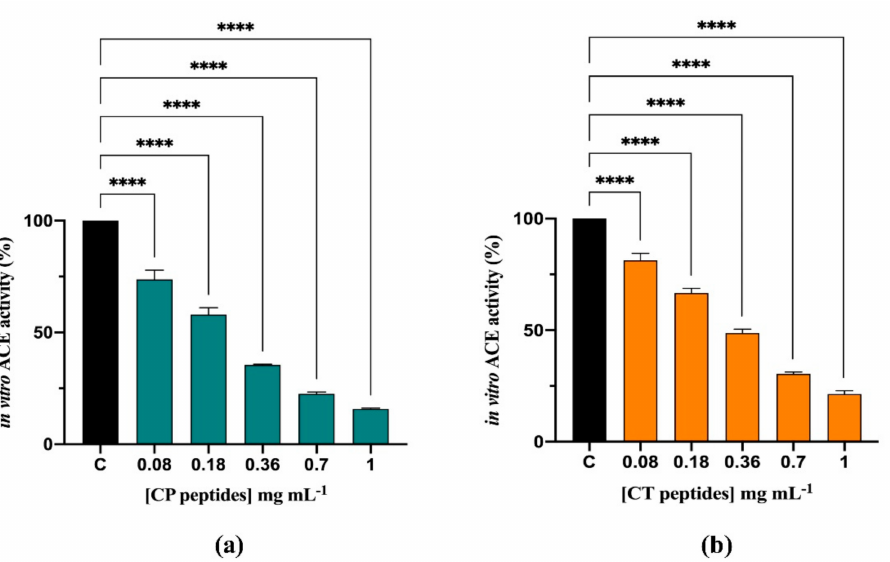
Figure 2. Evaluation of the in vitro inhibitory effects of CP ( a ) and CT ( b ) hydrolysates on ACE. Bars represent the sd of 3 independent experiments in duplicate. **** p < 0.0001 versus Control sample (C).